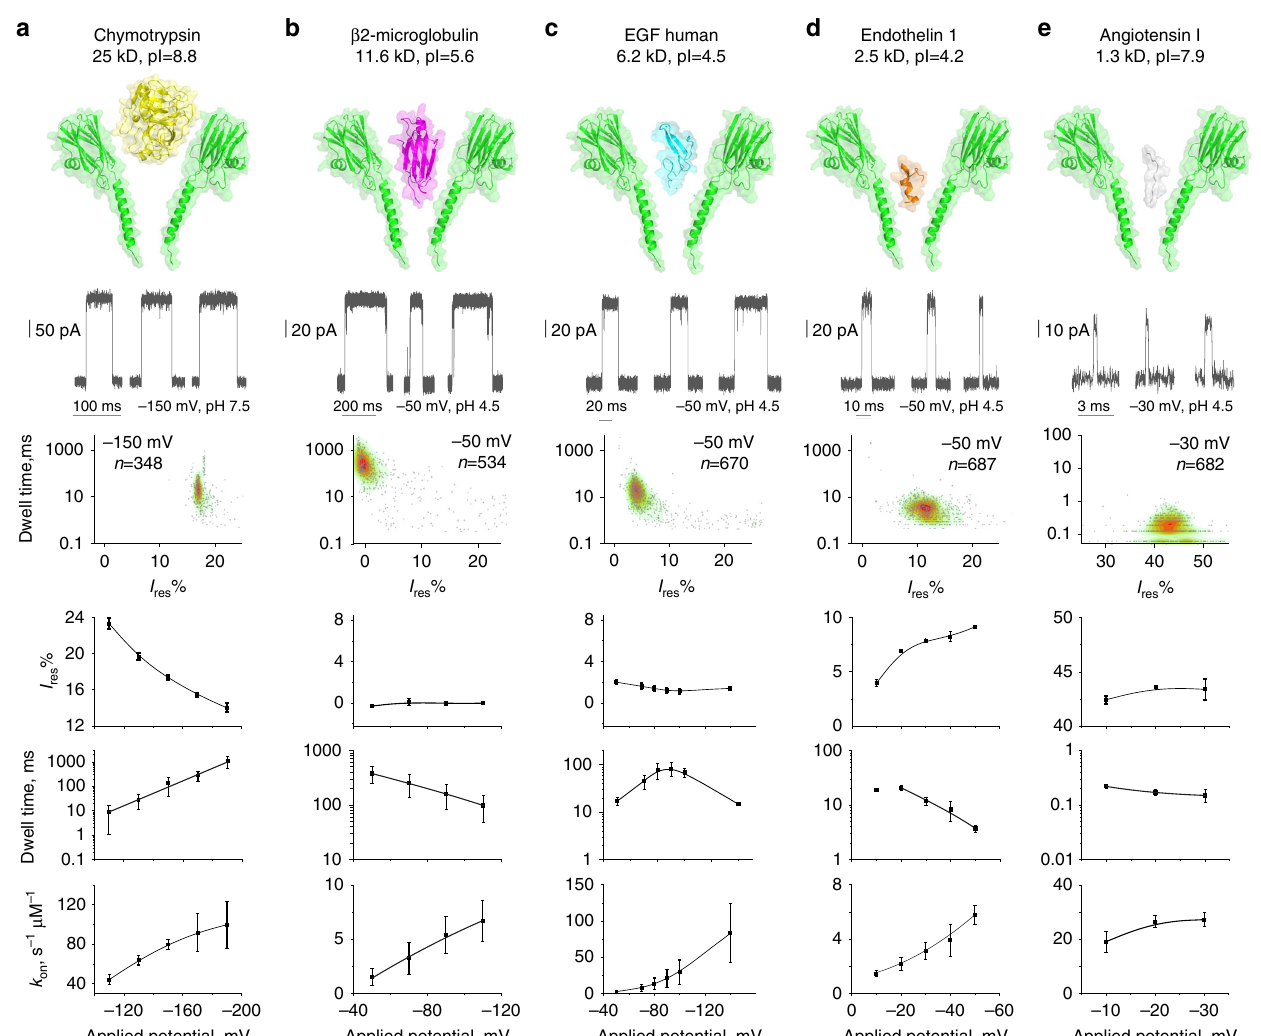
Fig. 3 Biomarker characterization with WtFraC at pH 4.5. From top to bottom: surface representation with molecular surface and cartoon representations (PyMOL) of the biomarker, a representative trace obtained under the indicated applied potential, a heatplot depicting the dwell time distribution vs. I res% at the same applied potential, the voltage dependence of I res% , the voltage dependence of the dwell times, and the capture frequency. a Chymotrypsin (25 kD, PDB: 5CHA), b β 2-microglobulin (11.6 kD, PDB: 1LDS), c human EGF (6.2 kD, PDB: 1JL9), d endothelin 1 (2.5 kD, PDB: 1EDN), and e angiotensin I (1.3 kD), respectively. Angiotensin I is depicted as a random structure drawn with PyMOL. The concentrations of the biomarkers were: 200 nM for chymotrypsin, 200 nM for β 2-microglobulin, 2 µ M for human EGF, 1 µ M for endothelin 1, and 2 µ M for angiotensin I, respectively. Isoelectric points of biomarkers are obtained from literatures or with the online calculation tool PepCalc. Error bars represent the standard deviation obtained from at least 3 repeats and at least 300 events for each repeat. The voltage dependencies of capture frequencies were fi tted to quadratic functions. With the exception of EGF, voltage dependencies of dwell times were fi tted to single exponentials. All remaining data were fi tted using a B-spline function (Origin 8.1). All recordings